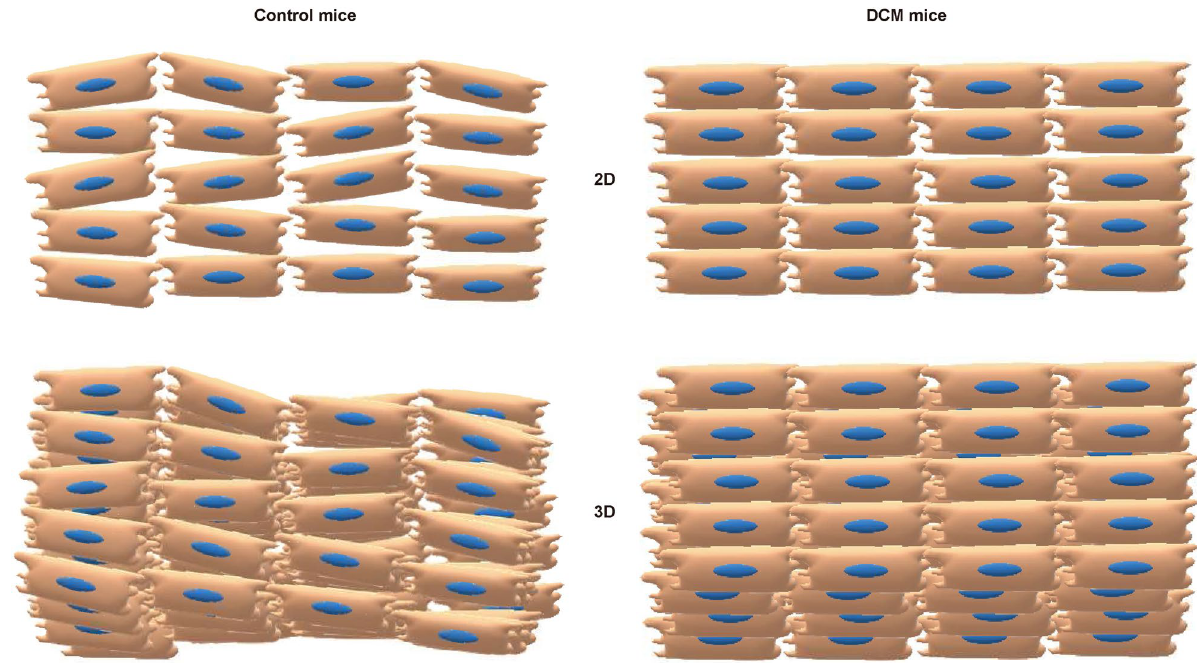
Figure 6. DCM mice show homogeneous 2D and 3D alignment and loss of twist. Schematic images of cardiomyocyte alignment in mT/mG (Control) mice and mT/mG; TNNT ΔK210/ΔK210 (DCM) mice. Cardiomyocytes of DCM mice exhibited homogeneous alignment both in 2D and in 3D and loss of twist compared with Control